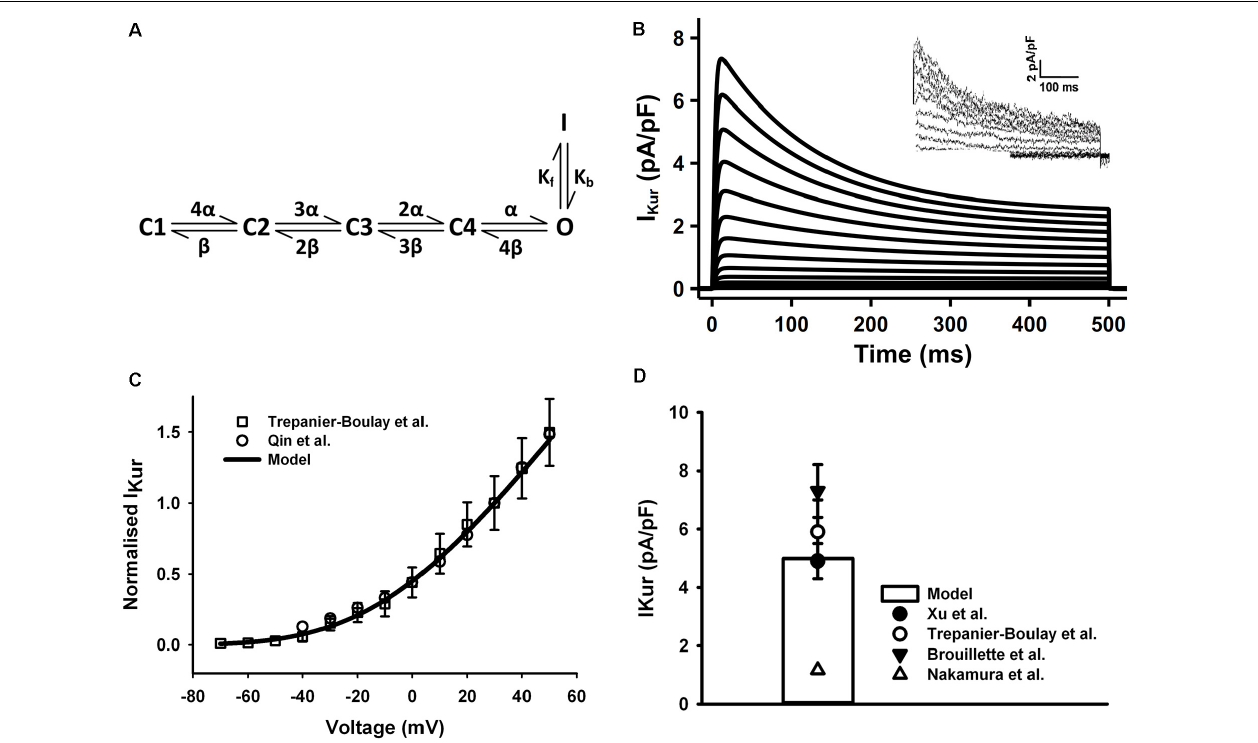
FIGURE 4 | I Kur in the atrial myocyte model and comparison with experimental data. (A) Schematic diagram of six-state Markov chain model of I Kur (Zhou et al., 2012). (B) Current traces for the corresponding voltage clamp protocol. The inset shows the experimental record from Trepanier-Boulay et al. (C) I–V relationship, current densities were normalized to the current at +30 mV. (D) Current density when clamped to +30 mV (Experimental data: Xu et al., 1999c; Brouillette et al., 2004; Trépanier-Boulay et al., 2004; Nakamura et al., 2010; Qin et al.,